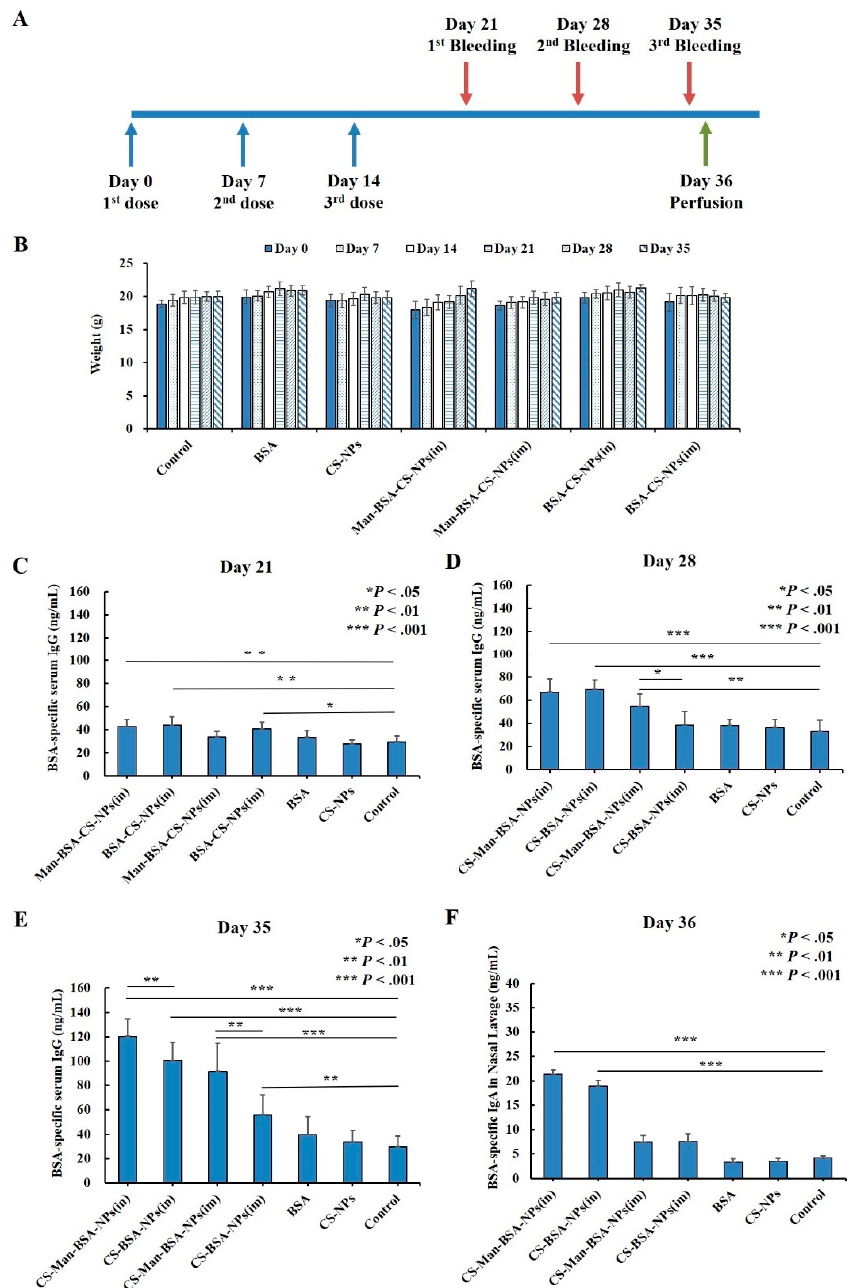
Figure 12. Immunization and sampling timeline ( A ); changes in body weight of mice ( B ); BSA-specific serum IgG ( C – E ) and nasal lavage fluid (NLF) IgA ( F ) antibody responses; all results are reported as mean (SD) ( n = 6, * p < 0.05, ** p < 0.01, *** p < 0.001).